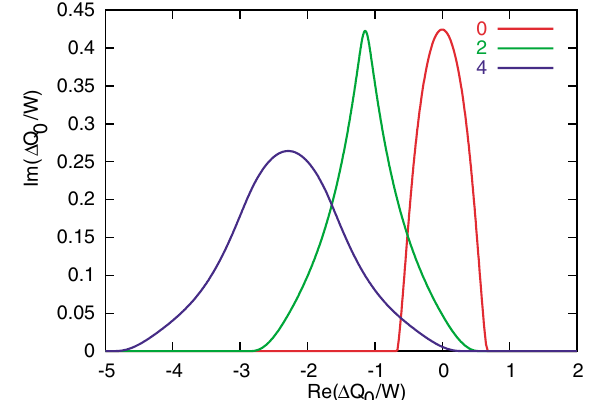
FIG. 18. (Color) Threshold diagrams for various values of =W and highly nonlinear space charge with q=E (cid:5) (cid:26) Q sc ; max 3 = 5 . Tune shifts corresponding to points below a given curve =W are stable for that value of (cid:26) Q sc ; max